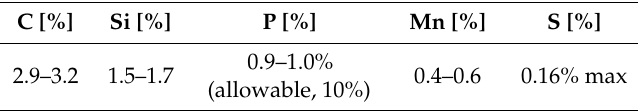
Table 1. Chemical composition is P 10 cast iron.